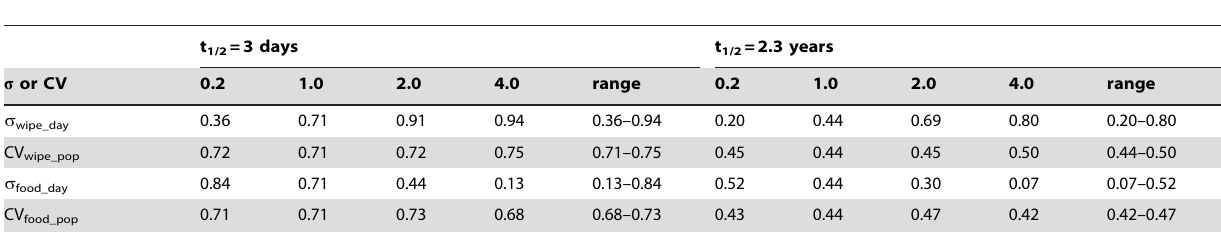
Table 1. Mean R 2 at a specific variability for four types of variability (coefficient of variation (CV) or standard deviation ( s )) for two compounds with different half-lives (t 1/2